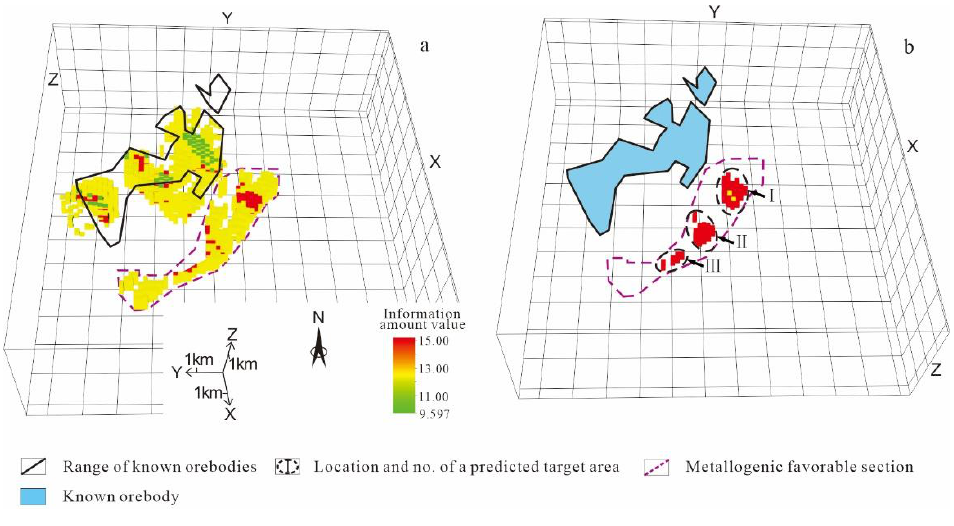
Figure 9. Deep metallogenic favorable zone ( a ) and the predicted deep target areas ( b ) in the Sanshandao fault.